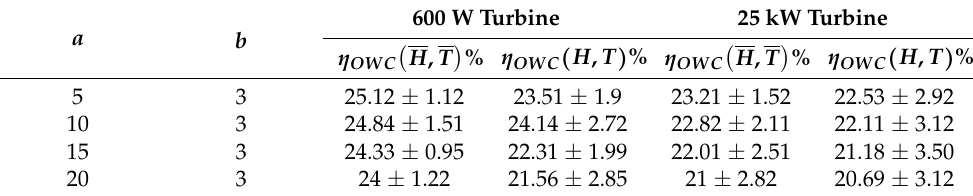
Table 3. Overall efficiency.